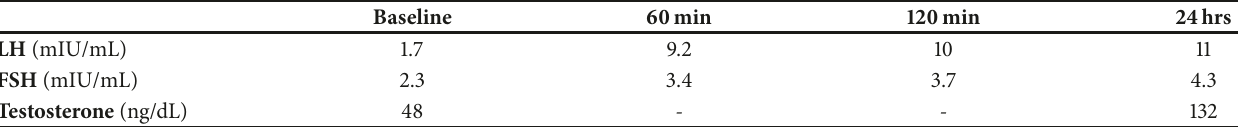
Table 2: GnRH agonist stimulation test (leuprolide acetate) done at the age of 10 years and 9 months using 20 mcg/kg/subcutaneous dose.